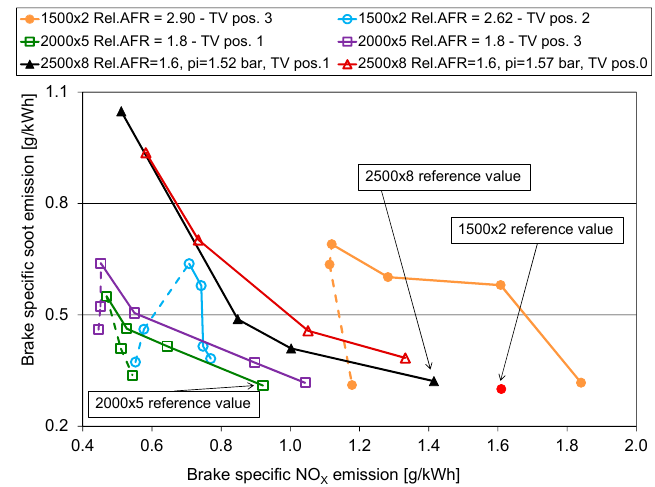
Figure 15. Trade-off between brake specific NO X and soot emissions in different operating modes.